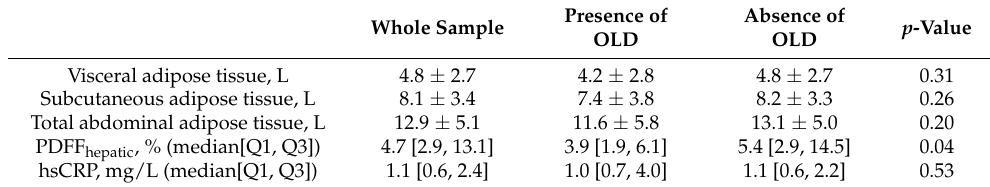
Table 2. Comparison of MR derived adipose tissue and hsCRP between the